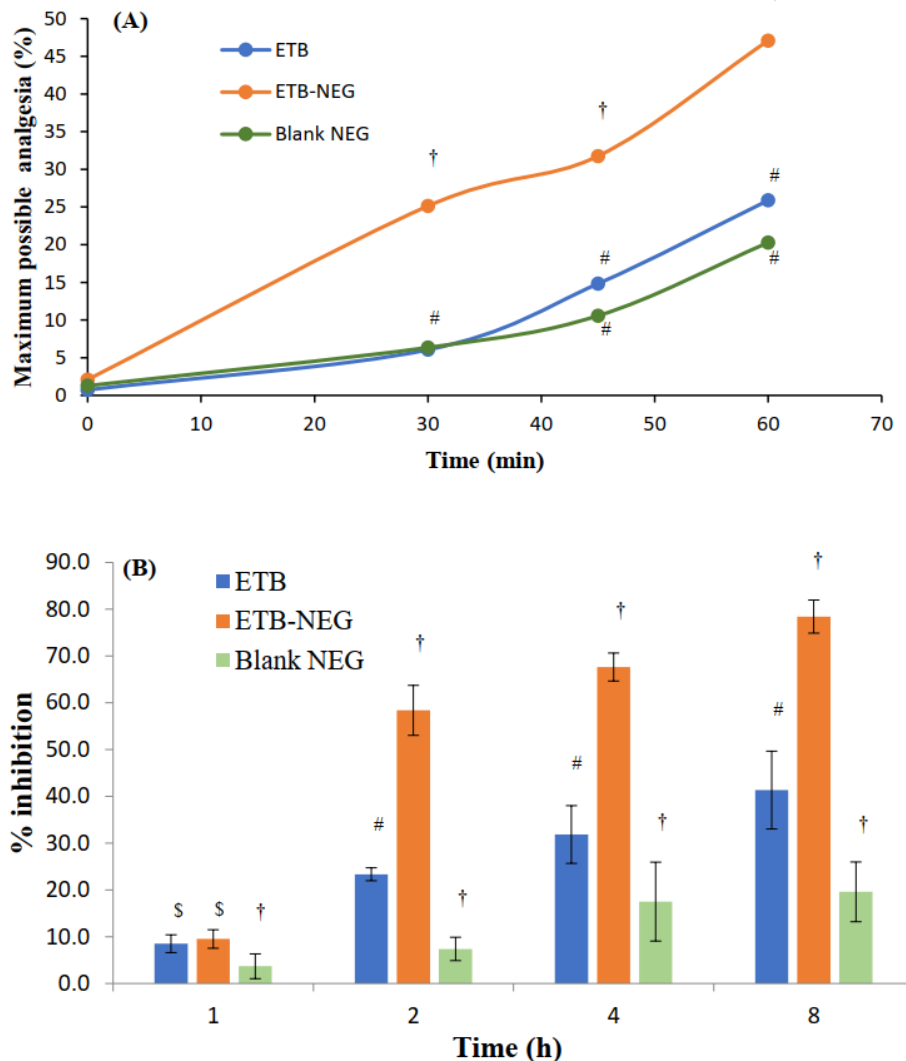
Figure 5. ( A ) Maximum possible analgesia (MPA) at time intervals of 0, 30, 45, and 60 min after treatment with ETB gel, ETB-NEG, and blank NEG. ( B ) Anti-inflammatory effects of ETB, ETB-NEG, and blank NEG samples in carrageenan-induced paw edema rats (Statistical inferences: †, p < 0.05, compared to ETB; #, p < 0.05, compared to ETB-NEG; $, p < 0.05, compared to blank NEG; ns, p > 0.05, not significant with any group).